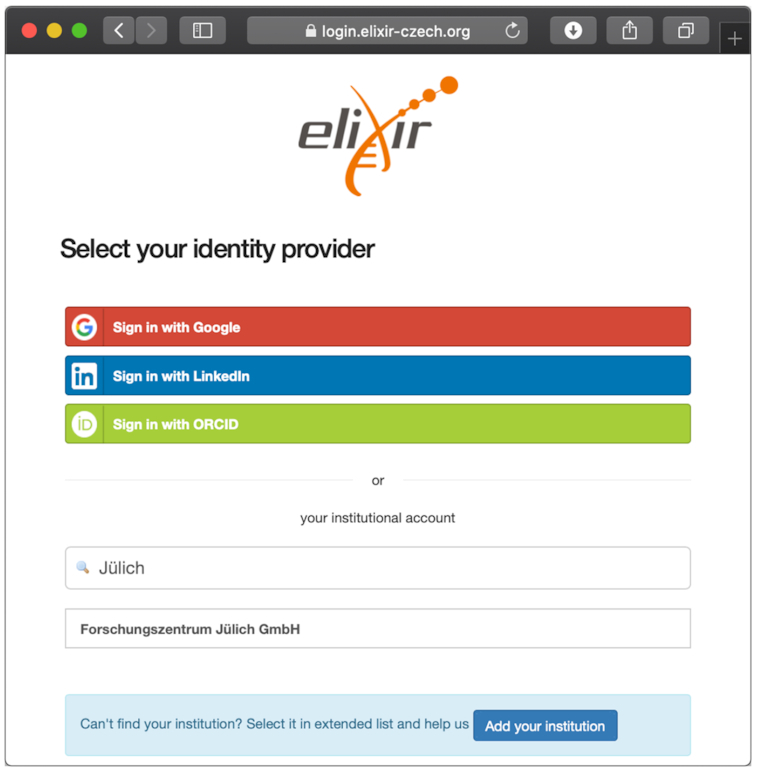
Integration of the ELIXIR AAI login dialog into the e!DAL infrastructure. In addition, the ELIXIR AAI provides a large collection of institutional identity providers, which can be easily found via the small search box, as well as several third-party login opportunities based on Google, ORCID, or LinkedIn. This provides the users a flexible authentication infrastructure.